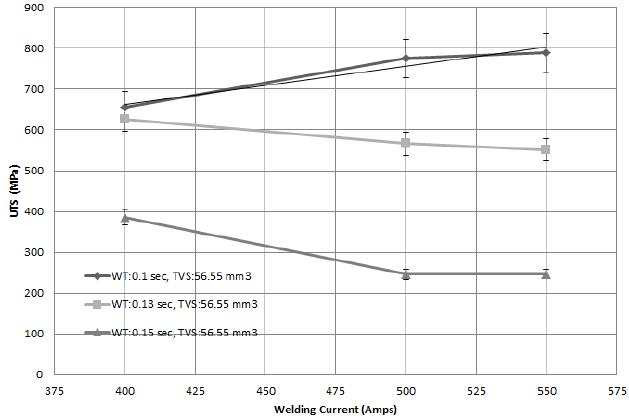
Figure 5. Variation of ultimate tensile strength with welding current.